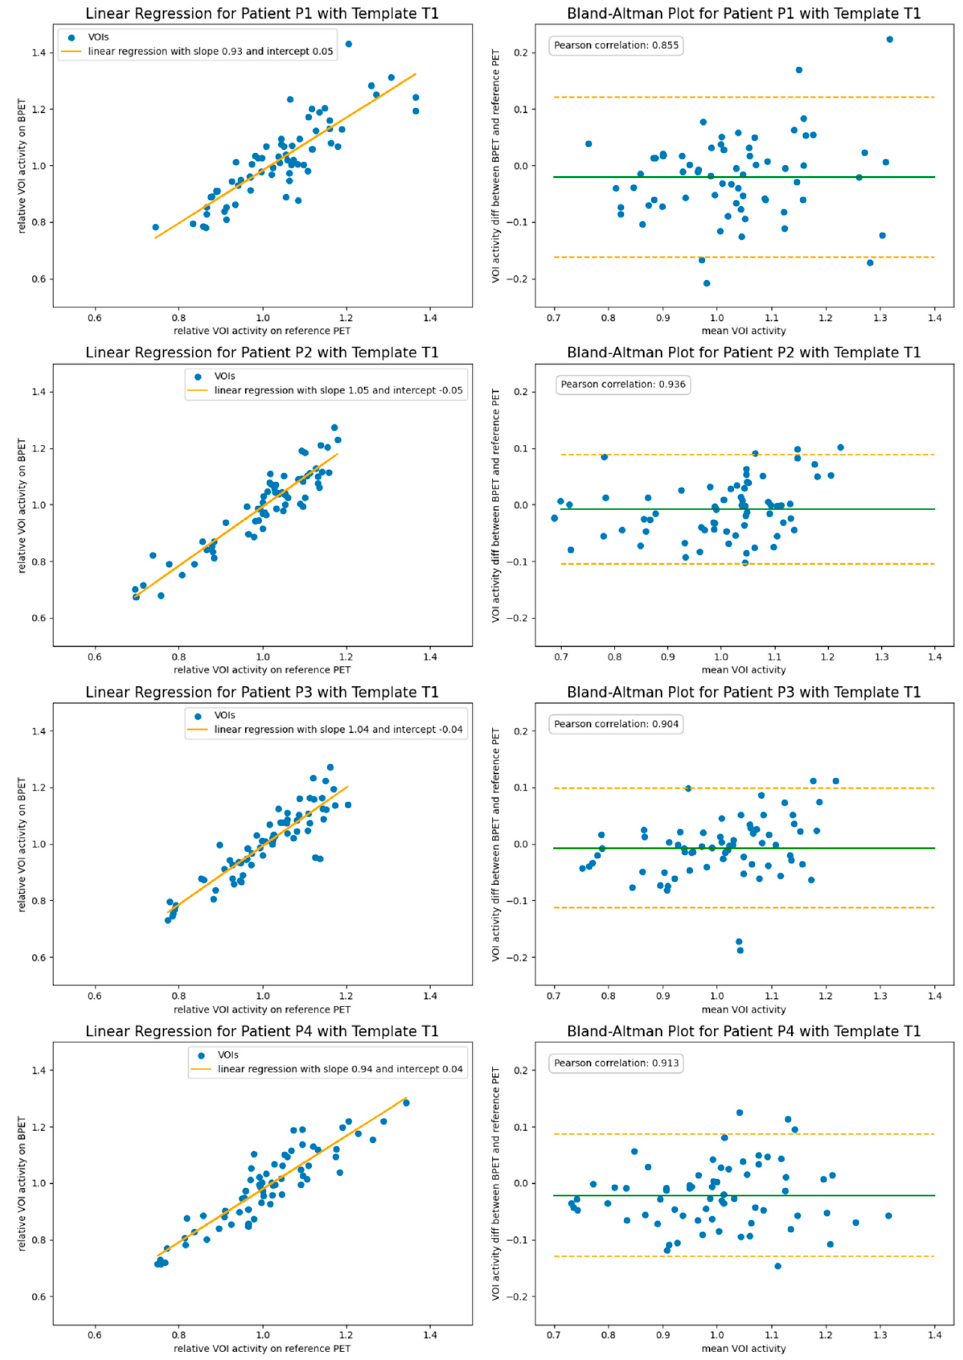
Figure 5. The VOI comparison of reconstructions using the independent template µ-map T1 for the attenuation correction with reconstructions from the reference PET/CT system. In the left column are the linear regression plots. Shown in the right column are Bland–Altman plots indicating the 1.96 SD bars (orange) at either side of the mean intensity ratio (green).